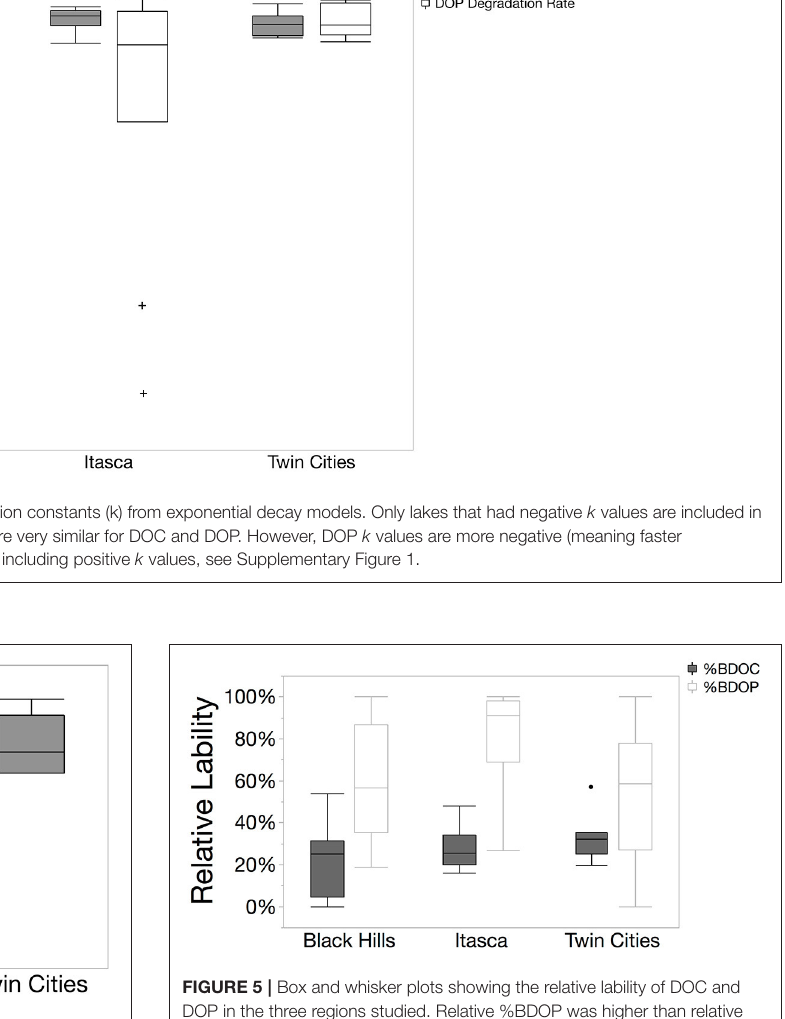
FIGURE 4 | Box and whisker plot showing the variability in kDOC:kDOP values across the three study regions. The Itasca region had a significantly lower value than the other two regions (Chi Square Median test, p = 0.0297) meaning DOP turnover was faster relative to DOC turnover in the Itasca region compared to the Black Hills and Twin Cities. The majority of samples form the Itasca region also had values less than 1, indicating that DOP was typically turning over faster than DOC in this region.